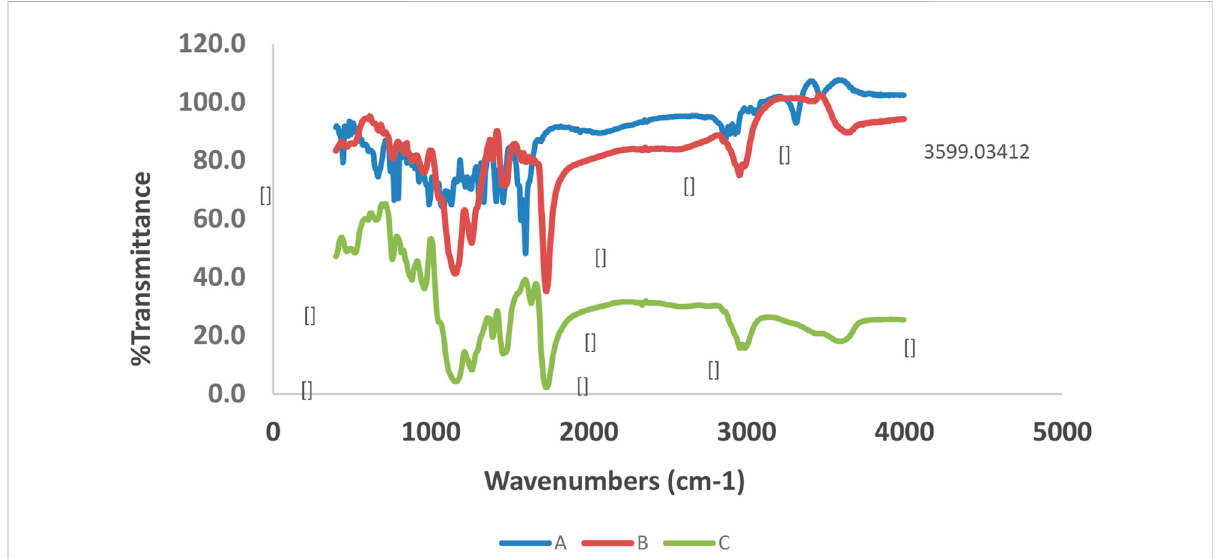
FIGURE 2 FT-IR spectra of quetiapine [ (A) ; blue line], drug-loaded MIP [ (B) ; brown line], and unloaded MIP [ (C) ; green line].